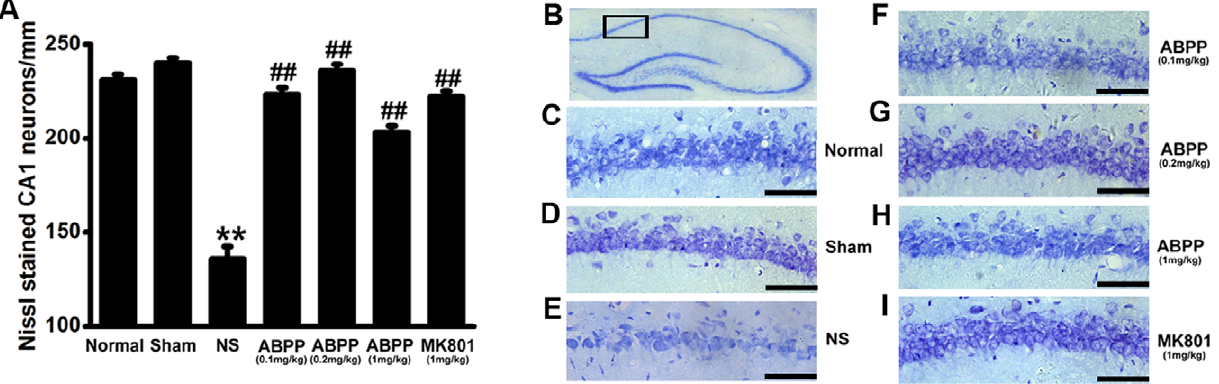
Figure 6. Effect of ABPP on the neuronal density in the CA1 region of hippocampus. Systemic administration of ABPP inhibited the decrease of neuron density induced by MCAO at 30 th day after MCAO (A). Schematic depicting hippocampal subregions of interest (B). Neuronal density taken by a representative rat from each group at 30 th day after MCAO (C-I; bar, 50 m m). Data are expressed as means 6 SEM (n=8); ** P , 0.01, compared to the Sham group; ## P , 0.01, compared to the NS